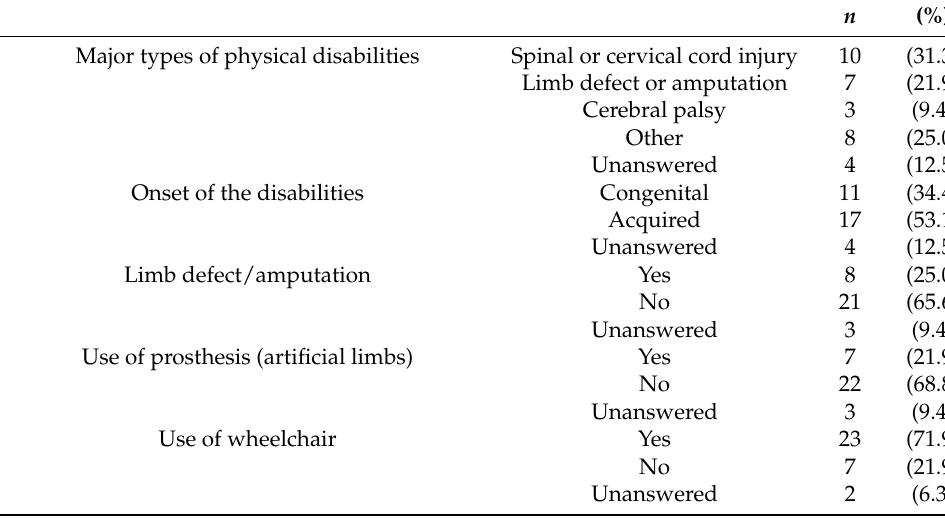
Table 1. Physical characteristics of